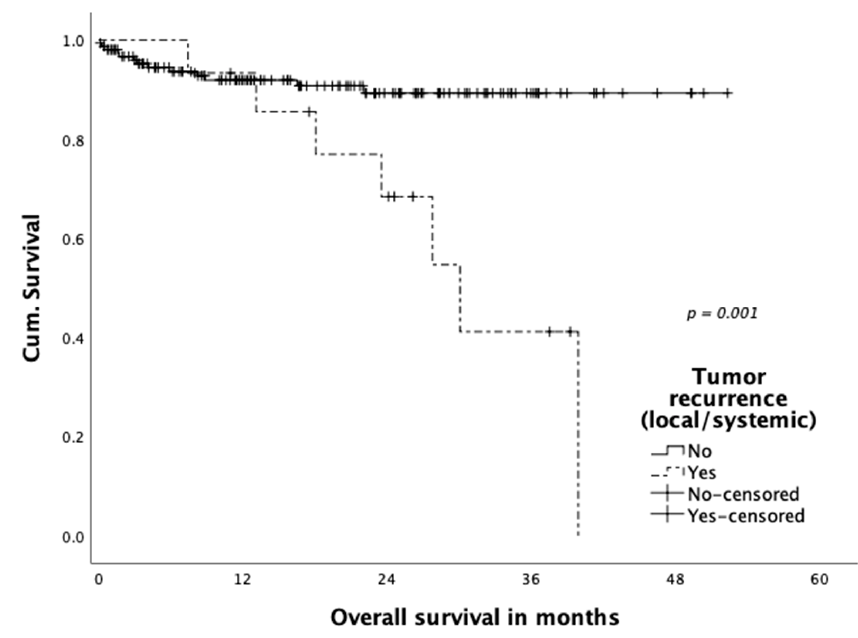
Figure 5. Overall survival according to tumor recurrence.